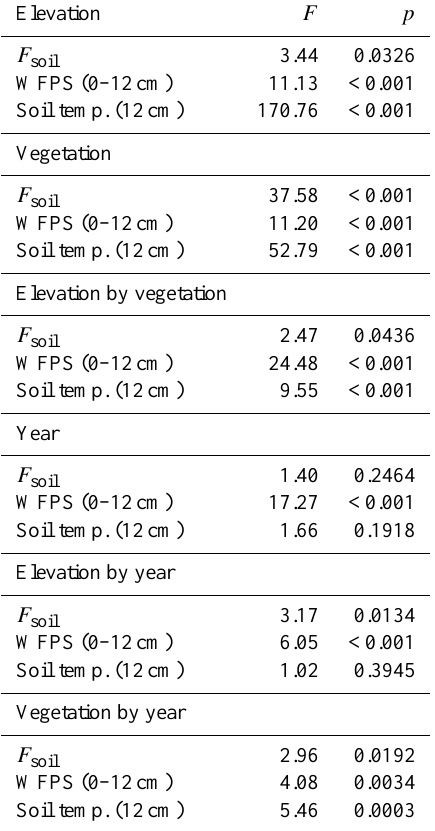
Table 2. Statistical table from repeated measures mixed-model ANOVA. For all comparisons by elevation, vegetation, and year, n = 633 and d f = 2633. For elevation by year and vegetation by year comparisons, n = 633 and d f =